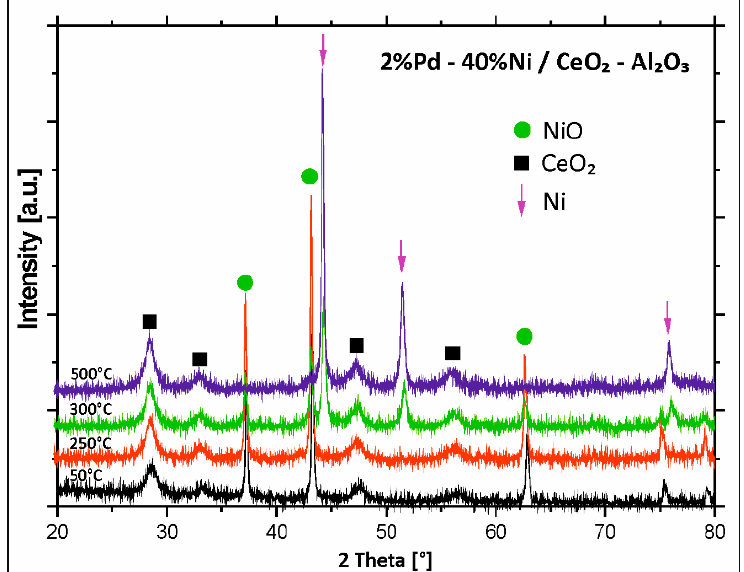
Figure 6. X-ray powder patterns recorded during reduction of calcined bimetallic Pd–Ni/CeO 2 –Al 2 O 3 catalyst in a mixture of 5%H 2 –95%Ar in the temperature range 50–500